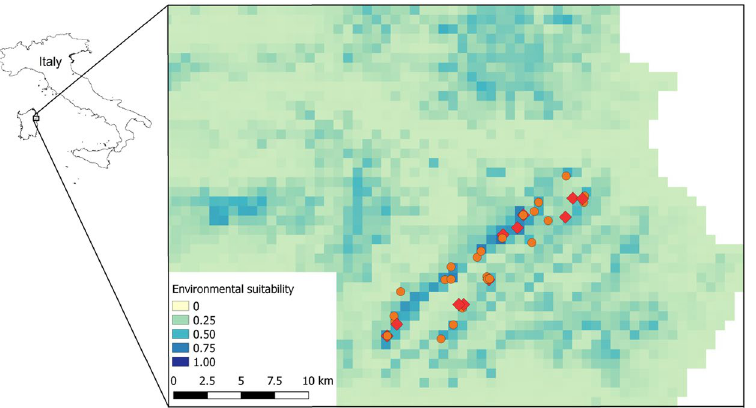
Figure 2. Distribution area of Hydromantes flavus , and environmental suitability estimated through the ensemble forecasting of multiple species distribution models. The background is limited to within 17 km north or west of the known presence records 26,60 . The map was built using the package biomod2 61 . Orange circles indicate all sites used to estimate suitability for the species; red squares represent sites surveyed in the present